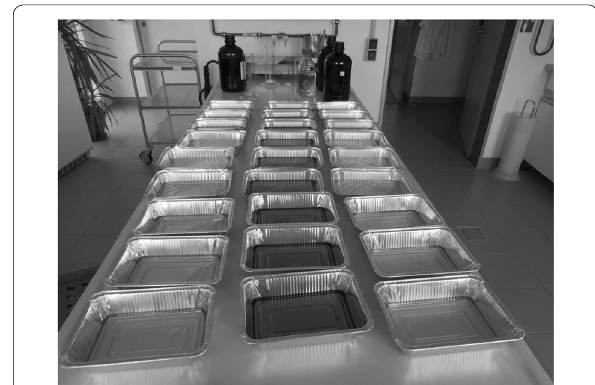
Fig. 1 Aluminum pans filled with food simulants for testing [ left row tap water, middle row olive oil, right row aqueous solution of 0.5% (w/v) citric acid]